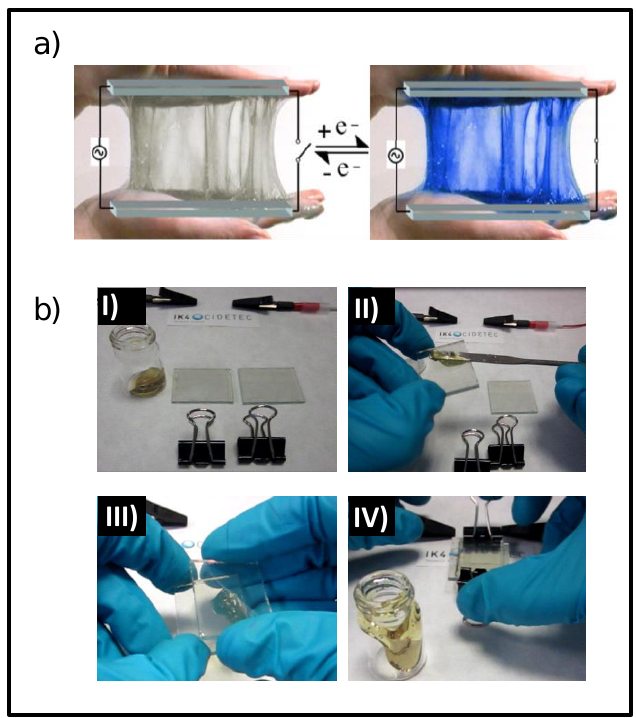
Figure 2. All-in-one gel-based ECDs comprising polyvinyl alcohol (PVA)–borax electrolyte: ( a ) Artistic representation of the device in the bleached (left) and colored (right) state. ( b ) Assembly process: ( I ) Required components: fluorine-doped tin oxide (FTO) glass electrodes, paperclips, and EC gel. ( II ) Application of EC gel to the electrode substrate; ( III ) sandwiching with the second electrode substrate; and ( IV ) clipping the electrodes. Adapted with permission from [126], copyright (2015) John Wiley and Sons, Inc.